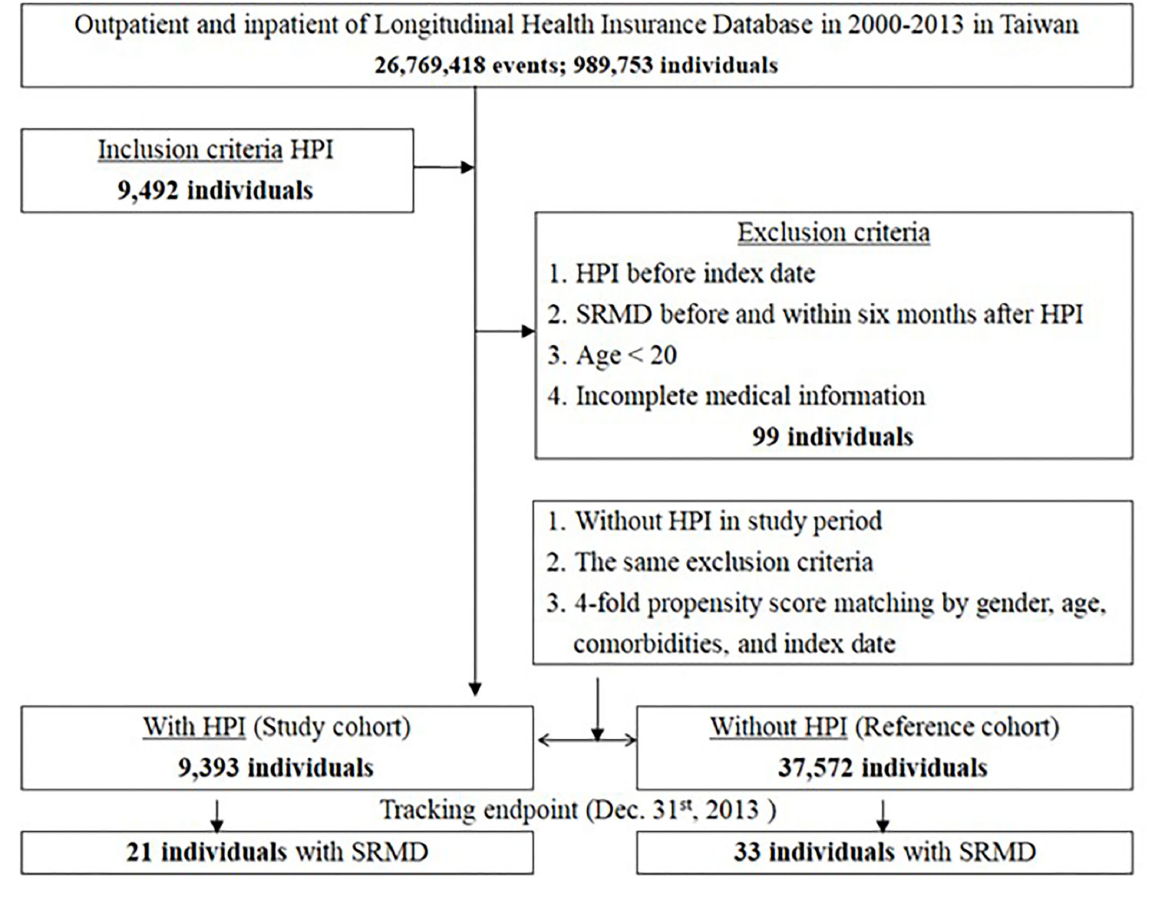
FIGURE1 The flowchart of study sample selection from The National Health Insurance Research Database in